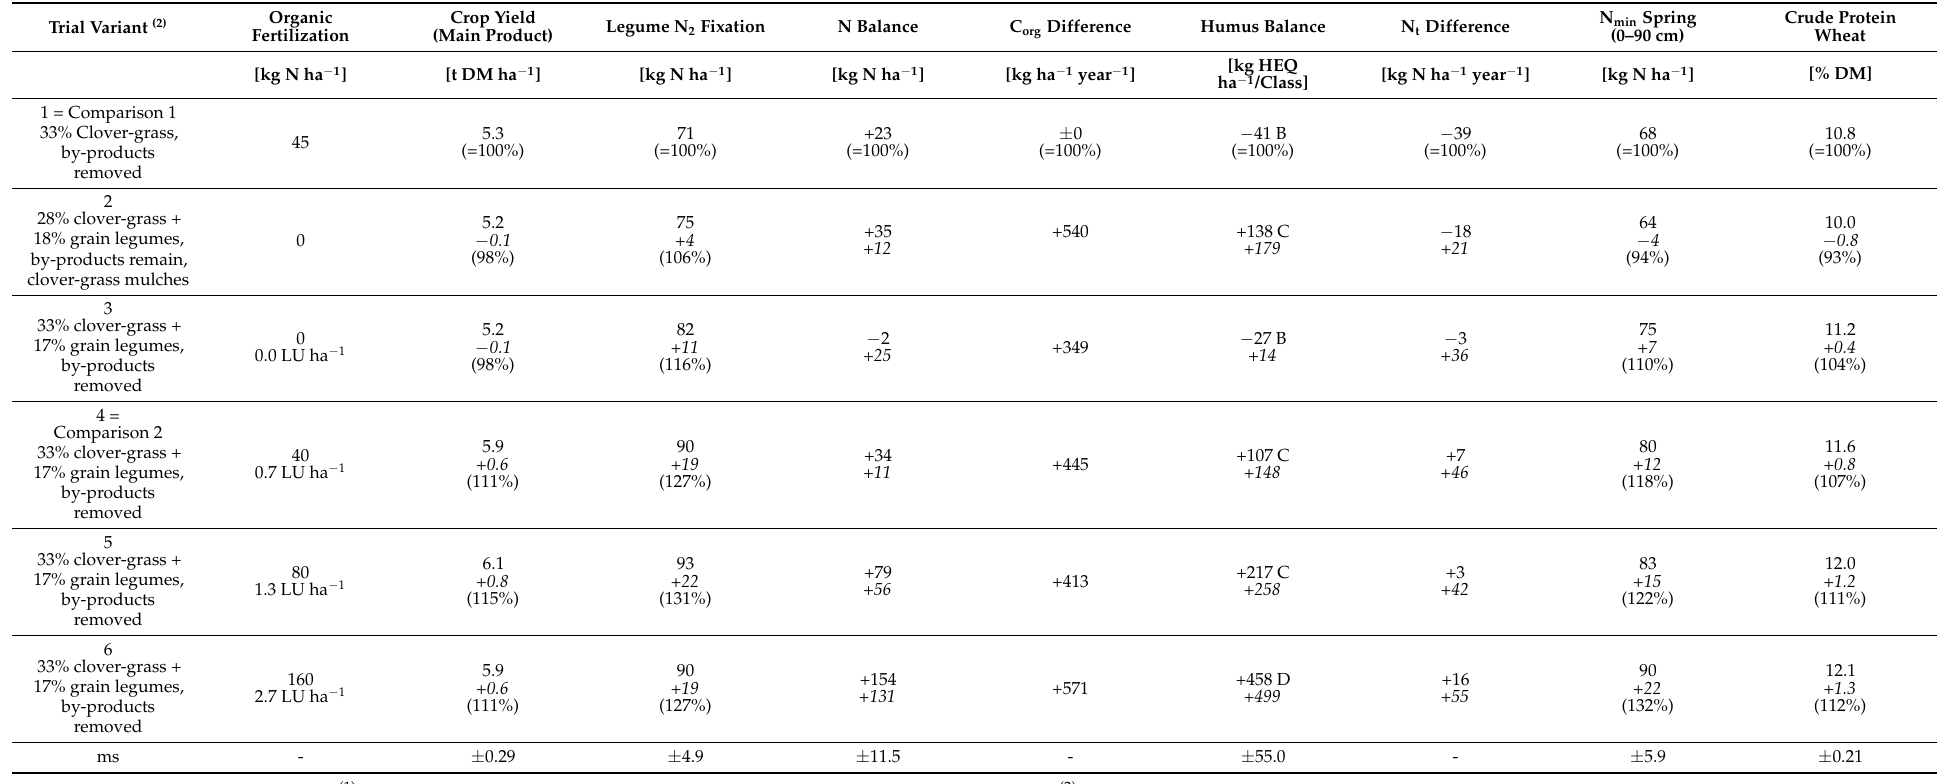
Table 11. Mean values as well as absolute (italics) and relative change (in parentheses) compared to a mean intensity [comparison 1 = 100%, see Table 2], and supply classes (1) of some important characteristics of plant and soil fertility of cropping systems with up to 50% crop rotation shares of forage and grain legumes